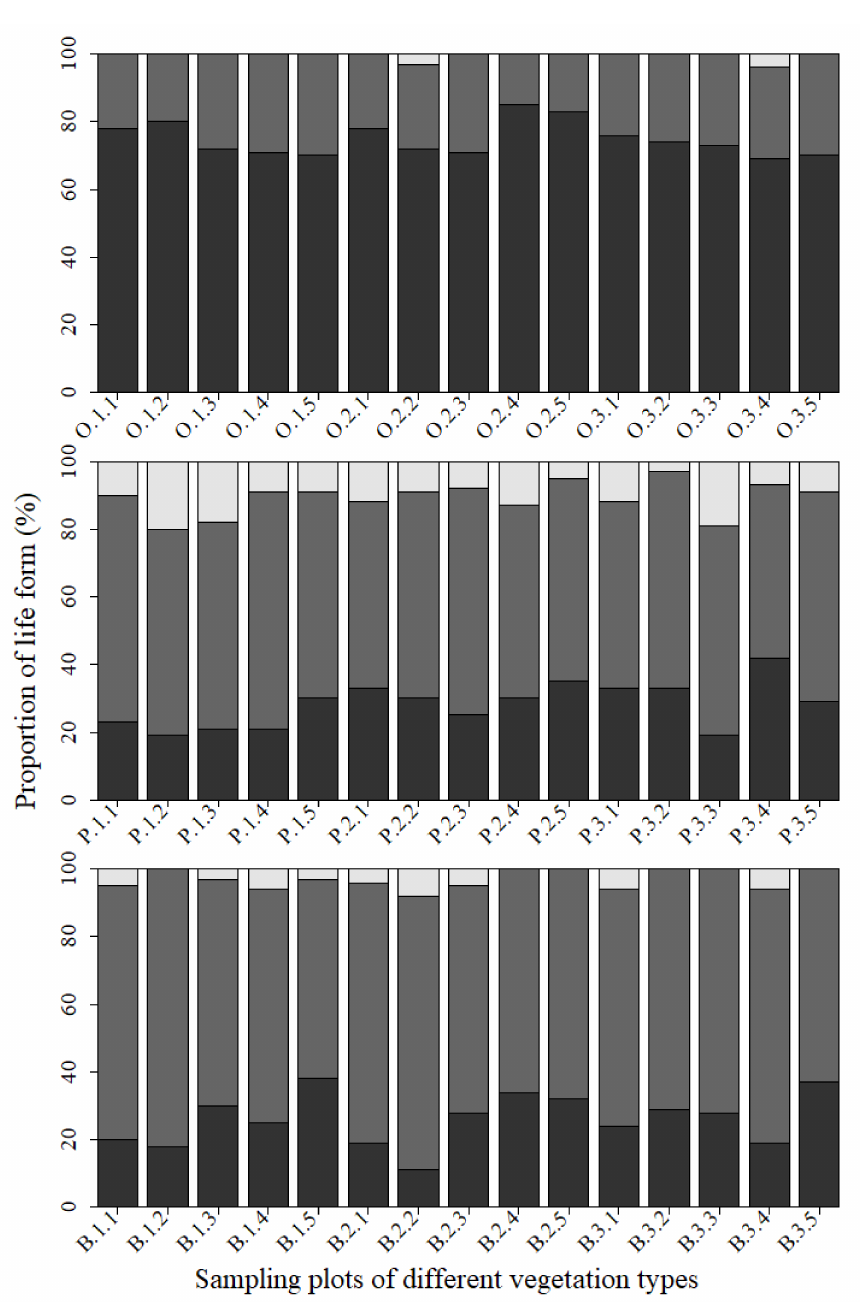
Figure 7. Soil seed bank life form spectrum of sampling points among different vegetation types. O, P and B represent the orchard, primary forest and bamboo shrub, respectively. The black column indicates annual herbs, the grey column indicates perennial plants (herbs and woody vines), and the white column indicates trees or